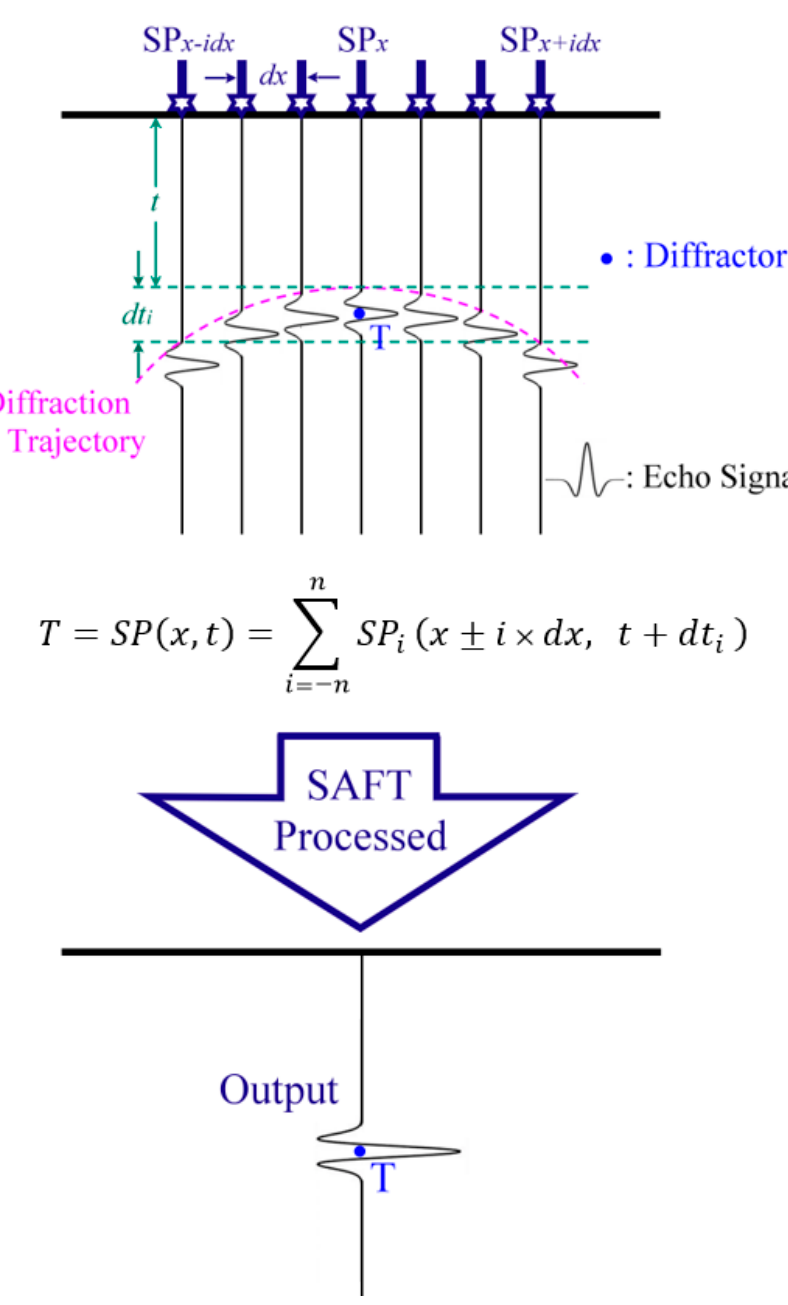
Figure 2. A brief description of the SAFT process.